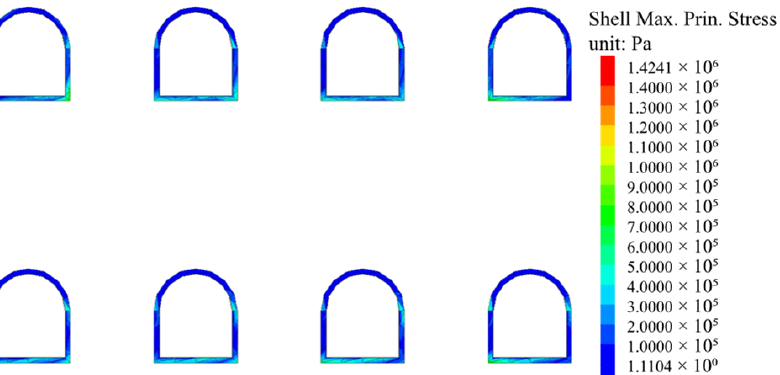
Figure 15. Maximum principal stress distribution of pilot tunnels supporting structure under seis- mic excitation.